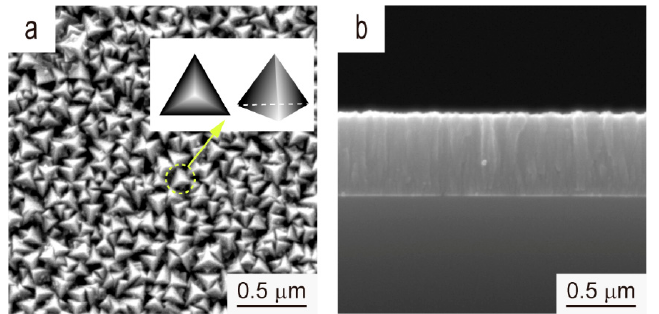
Figure 9. ( a ) Surface and ( b ) cross-sectional SEM images of the V film deposited on Si (100) at T s = 400 °C and D t-s = 60 mm.